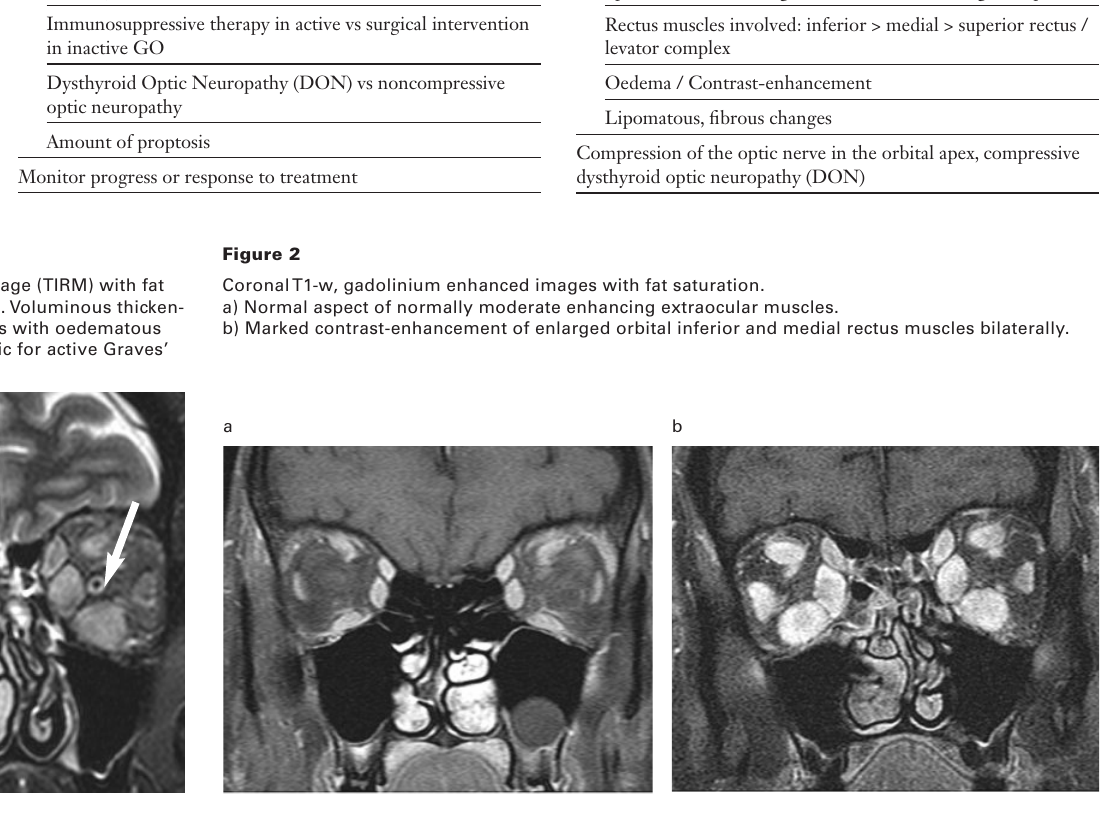
Indications for MR- imaging in Graves’ orbitopathy (modified according to [6]).